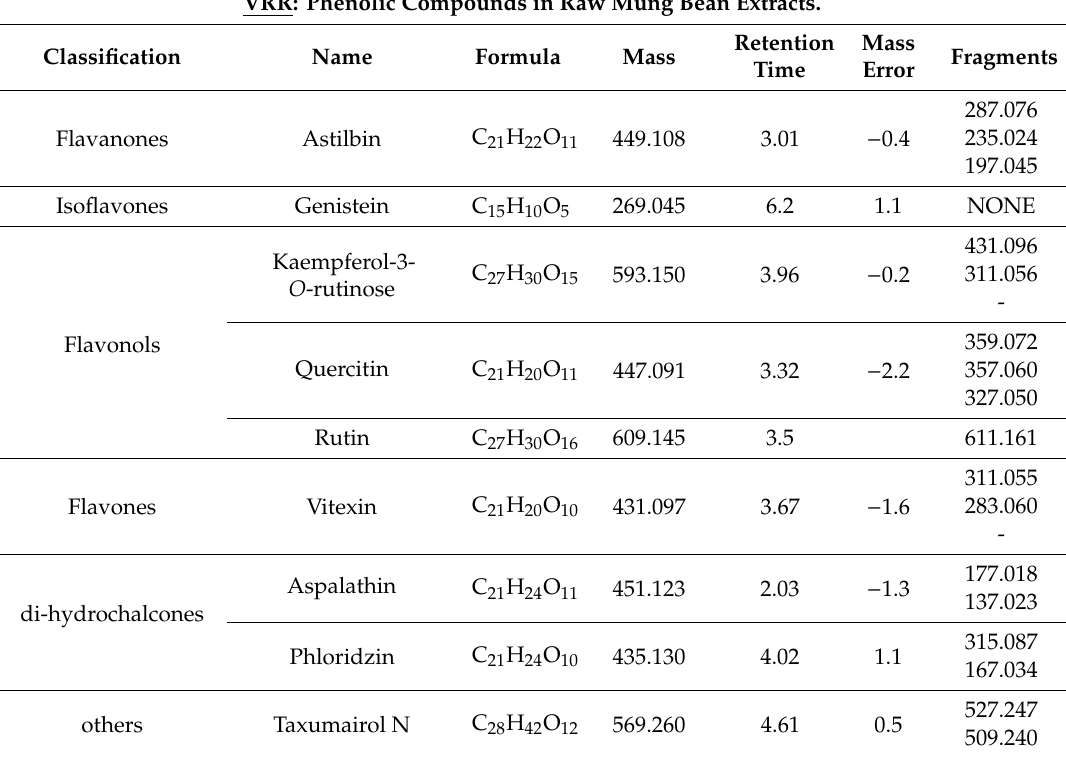
Table 5. Phenolic compounds in raw and 3-day-germinated mung bean extracts. VRR: Phenolic Compounds in Raw Mung Bean